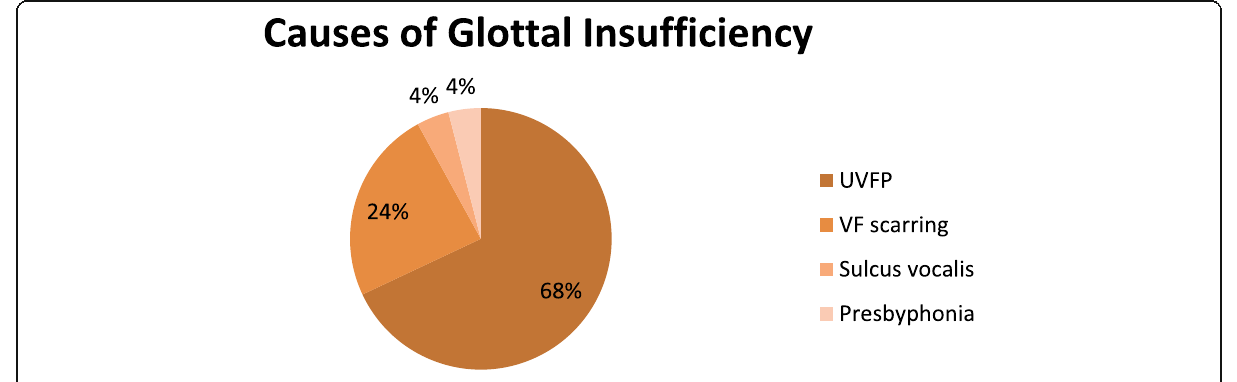
causes were upper respiratory tract infection in 2 pa- tients (11.7% of cases), cervical disc operation in 1 pa-